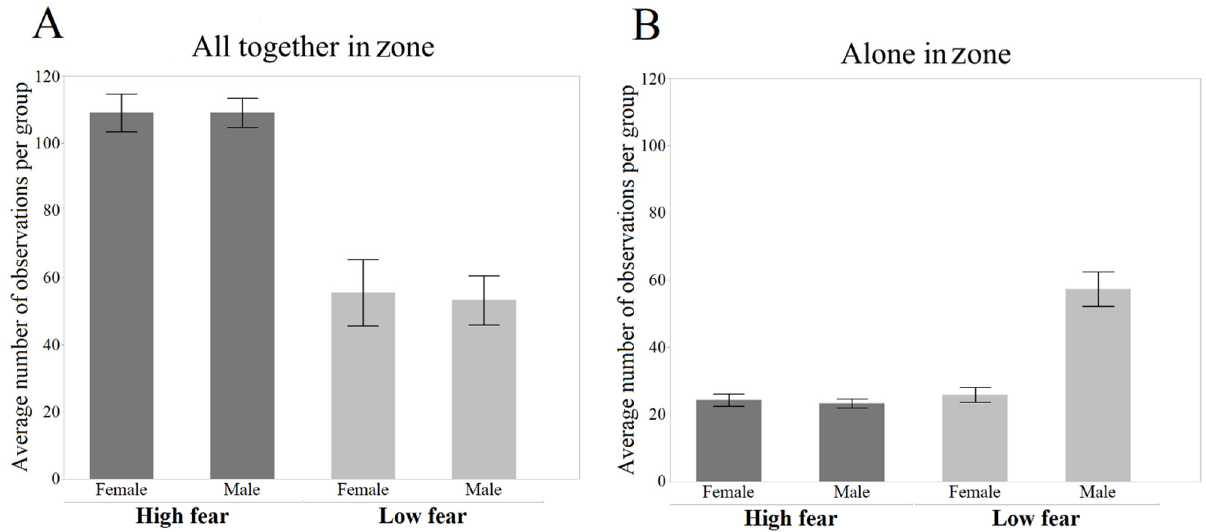
Figure 4. Observations of social proximity in the two selection lines (mean ± SE). ( A ) The number of observations of all four birds staying together in the same zone. ( B ) The number of observations of one bird staying on its own in a zone.